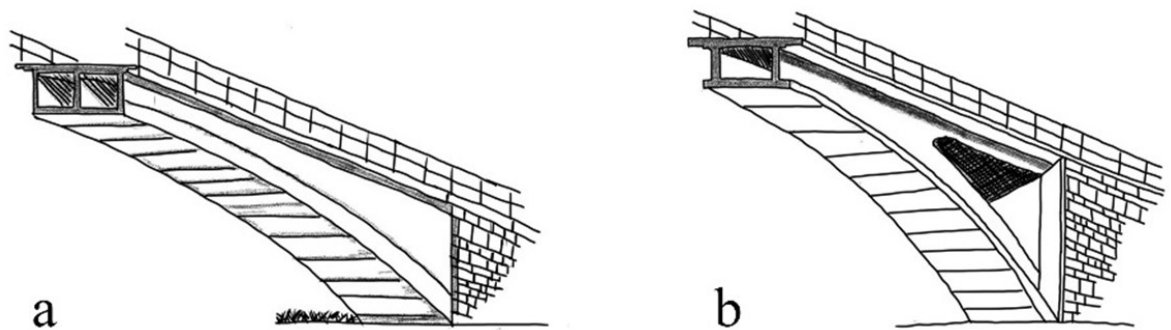
Figure 1. ( a ) Zuoz Bridge cross-section; ( b ) Tavanasa Bridge